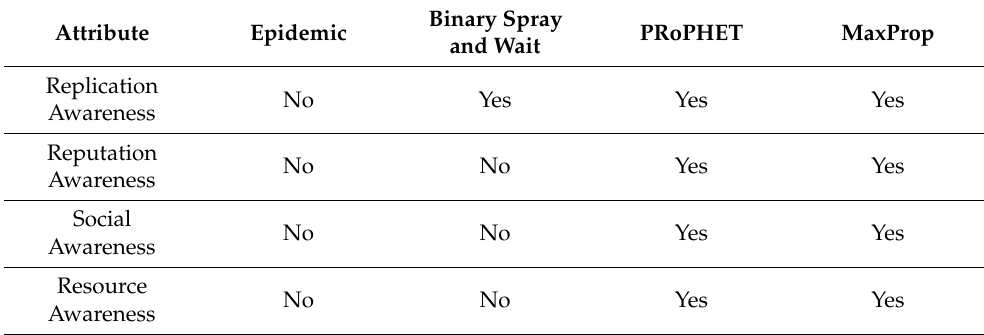
Table 1. Table to compare attributes of the